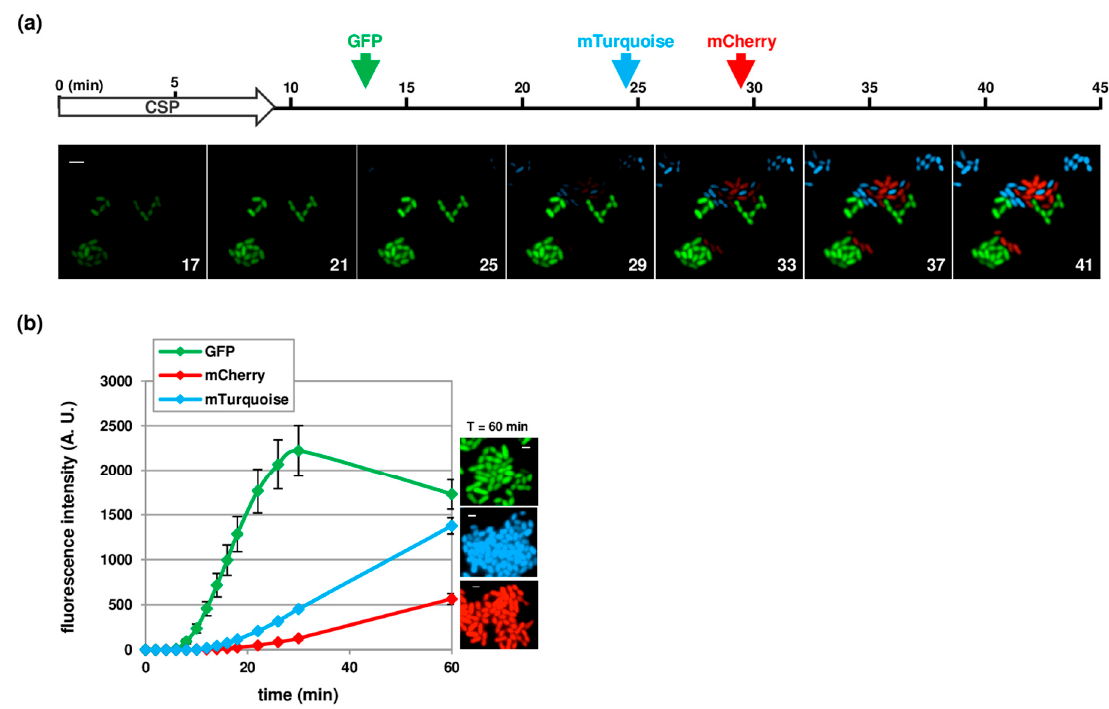
Figure 3. Comparison of the kinetics of expression of P E - gfp (strain R4254), P E - mTurquoise (strain R4255) and P E - mCherry (strain R4256) in response to CSP addition. ( a ) Still images from time-lapse microscopy of a mixed culture containing equal densities of all 3 strains. Images were captured at 2min intervals during 1 h. The starting point of the time-lapse corresponds to the beginning of CSP perfusion. First image shown corresponds to the 17th min. Every second image is shown. Time is given in minutes. Arrows indicate the initial time at which the fluorescence signal is visually detected for GFP (green), mTurquoise (blue) and mCherry (red). Overlays between GFP (green), mTurquoise (blue) and mCherry (red) are shown. Scale bar, 2 µ m; ( b ) Quantification analysis of fluorescence signal based on time-lapse microscopy images. Strains R4254, R4255 and R4256 were grown in parallel microfluidic chambers and induced to develop competence by CSP perfusion. Time zero corresponds to the onset of CSP perfusion. Images were captured at 2 min intervals. Average fluorescence intensities per µ m 2 are shown in arbitrary units (A.U.). More than 200 cells were analyzed per time point and per experiment. Lines and confidence bands represent means of three replicates and standard deviations, respectively. GFP (green), mTurquoise (blue) and mCherry (red) fluorescence images acquired at 60 min are shown on the right side. Scale bar, 1 µ m.